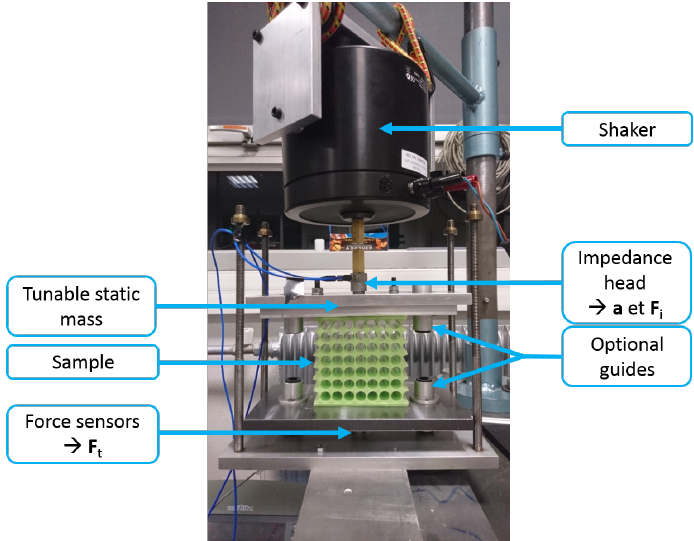
Figure 8. Test bench for vibration isolation measurements.